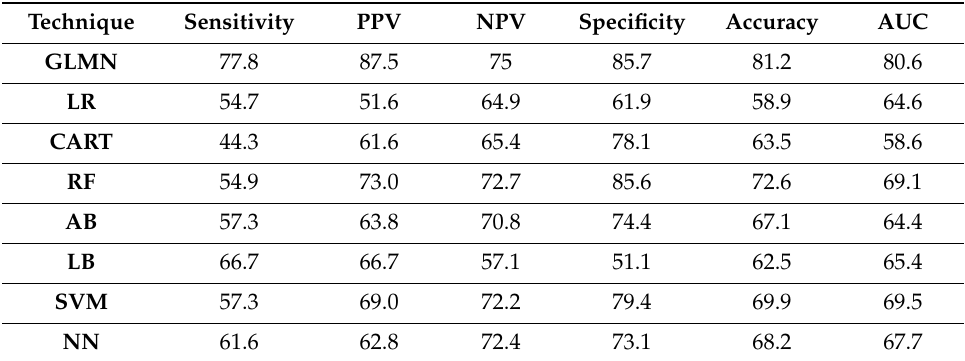
Table 2. Performance of generalized linear model net (GLMN), logistic regression (LR), classification and regression tree (CART), random forest (RF), adaboost (AB), logitboost (LB), support vector machine (SVM), and neural network (NN) obtained with complete case (CC) analysis. The values represent sensitivity, positive predictive value (PPV), negative predictive value (NPV), specificity and accuracy averaged over the values obtained on each resample.